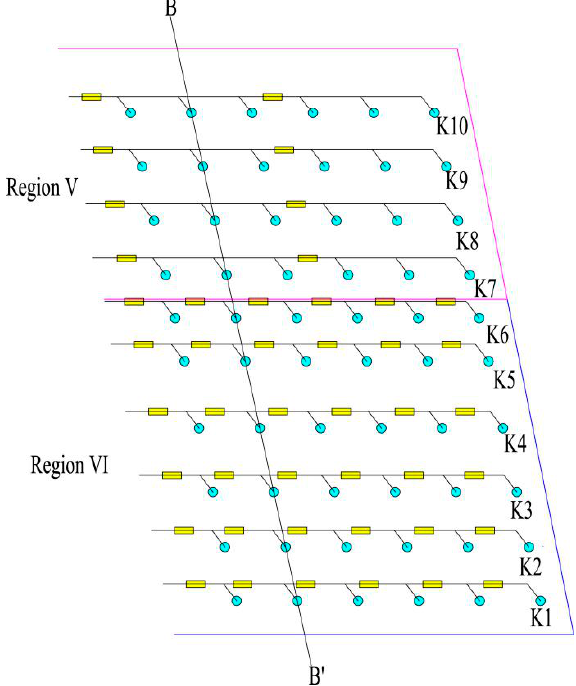
Figure 11. Recommended blast network of region Ⅴ and region Ⅵ .